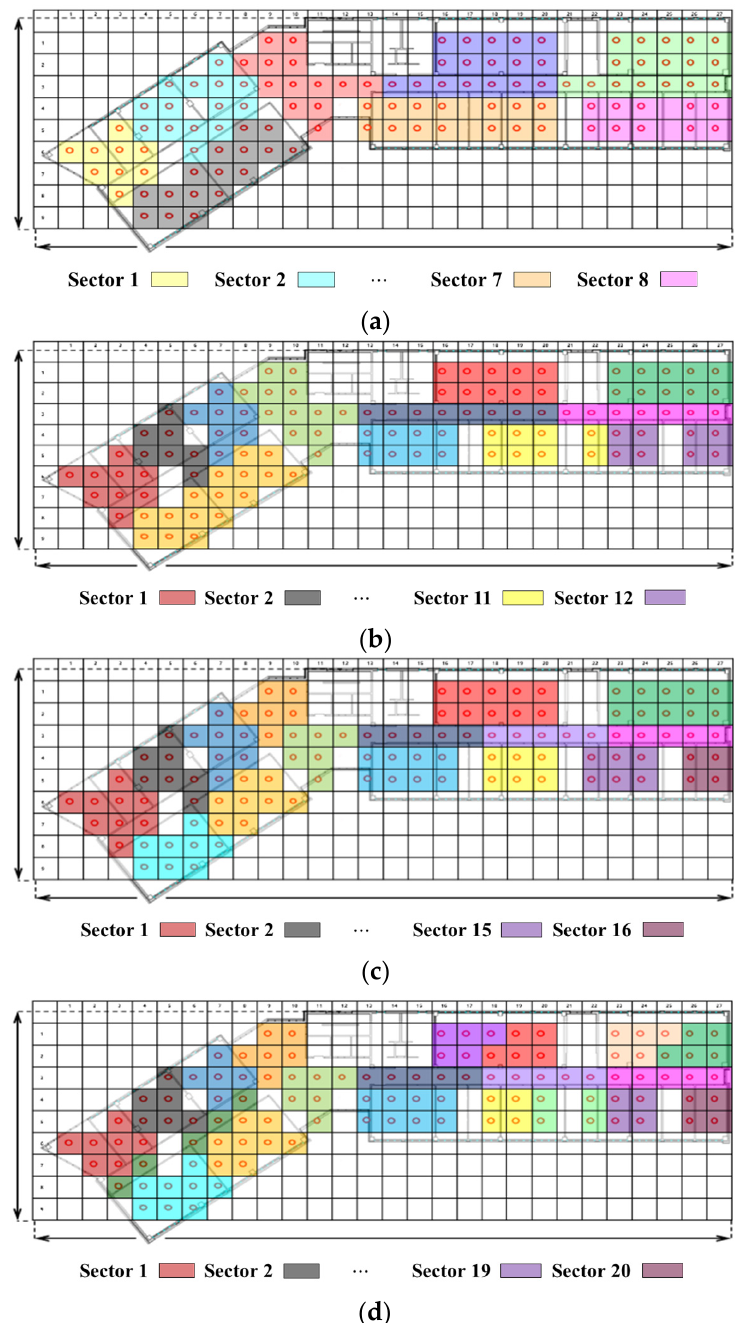
Figure 16. AP allocation partitions for each sector in the experimental environment divided by ( a ) 8, ( b ) 12, ( c ) 16, and ( d ) 20.